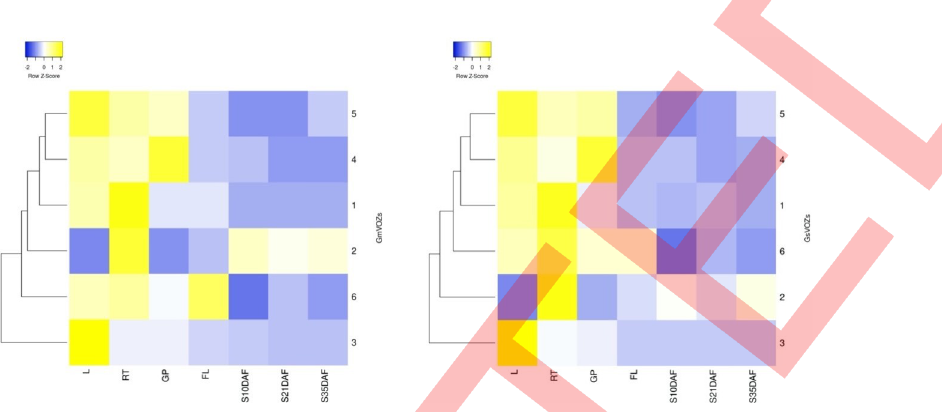
Fig 6. Expression analysis of GmVOZs and GsVOZs genes at different developmental stages in specific organs. Leaves (L), Roots (RT), Green Pods (GP), Flower (FL), Seed 10, 21, 35 days after flowering.